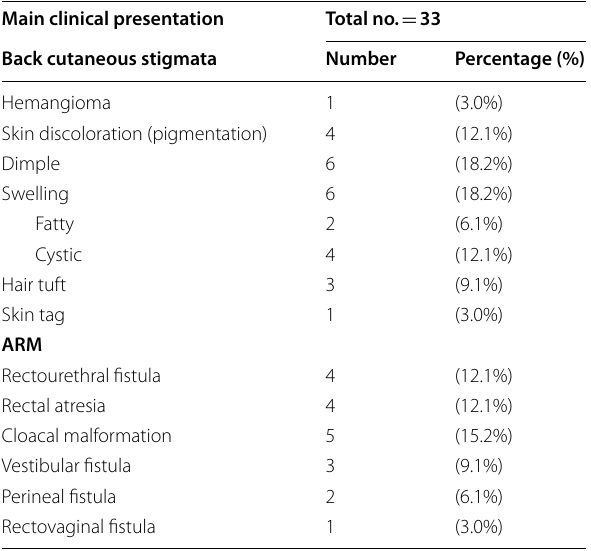
Table 1 Distribution of study population in terms of main clinical presentation